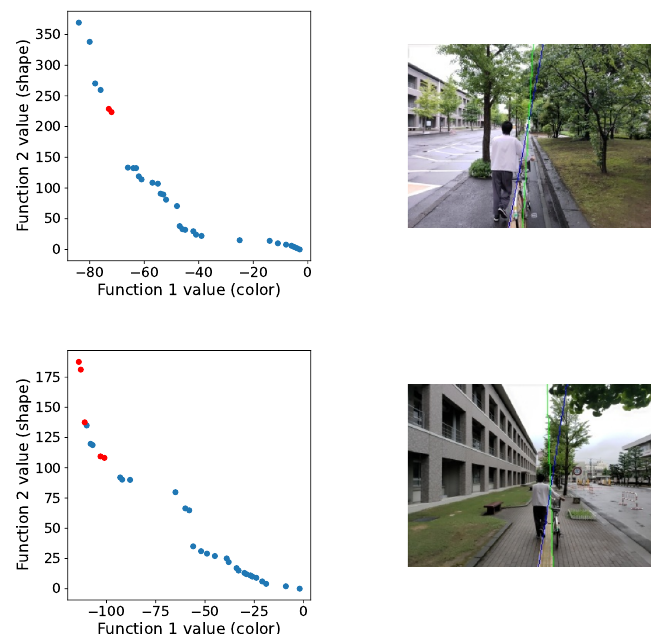
Figure 11. Pareto front approximation of NSGA-II in the final generation. The blue circles show the non-dominated solutions, and the red circles show the selected solution for final decision making (i.e., the average of the red circles is the final result plotted on the right